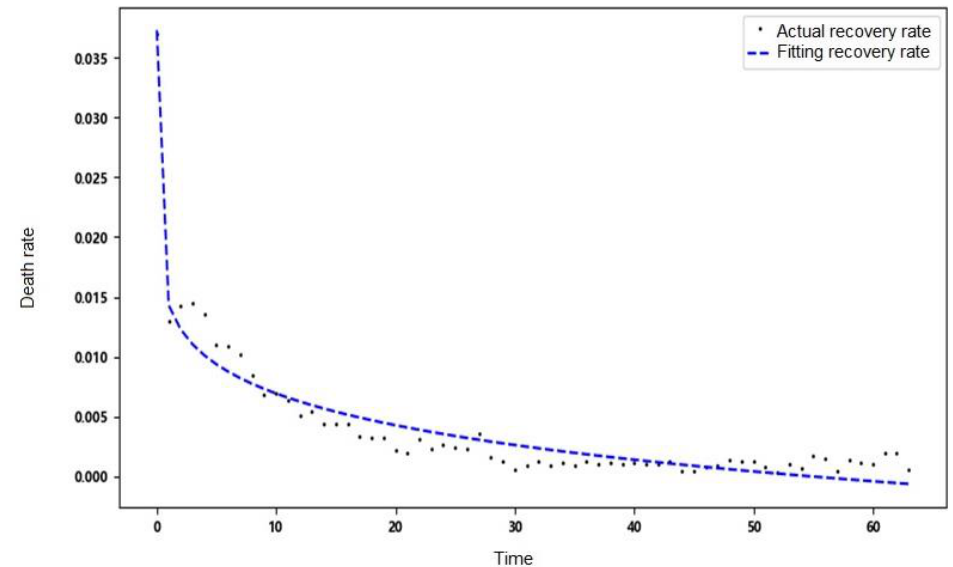
Figure 3. Fitting results of daily recovery rate.